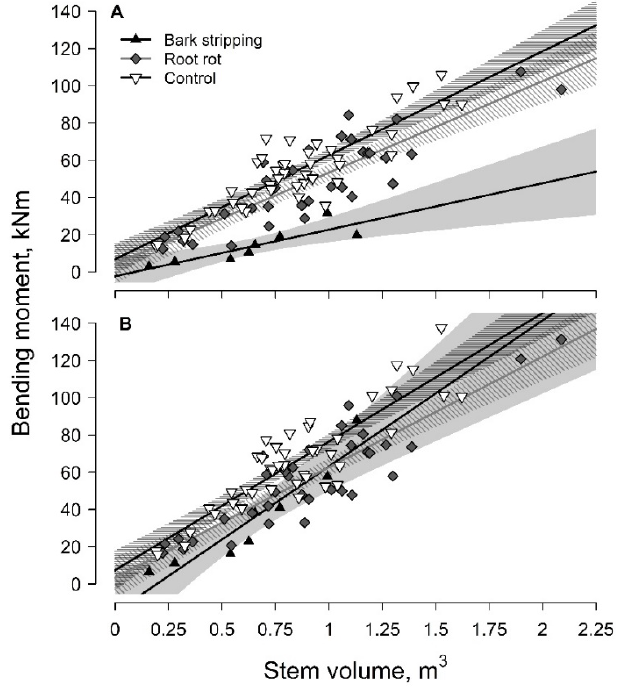
Figure 1. Estimated effects of bark-stripping and root-rot on the basal bending moment of Norway spruce at primary ( A ) and secondary failures ( B ). Table 1. Strength (Wald’s χ 2 ), significance ( p -value), random effect of stand, and performance ( R 2 ) of the linear mixed-effects models characterizing the effect of biotic disturbances on the basal bending moment of Norway spruce at the primary and secondary failures, under static loading. σ 2 —total variance of response; τ 00 —variance related to random effects (site); ICC—intraclass correlation